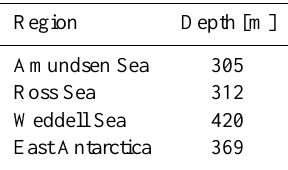
Table 1. Mean depth of ice shelves in the different regions denoted in Fig. 2 as computed from Le Brocq et al. (2010). Oceanic temper- ature anomalies were averaged vertically over a 100m range around these